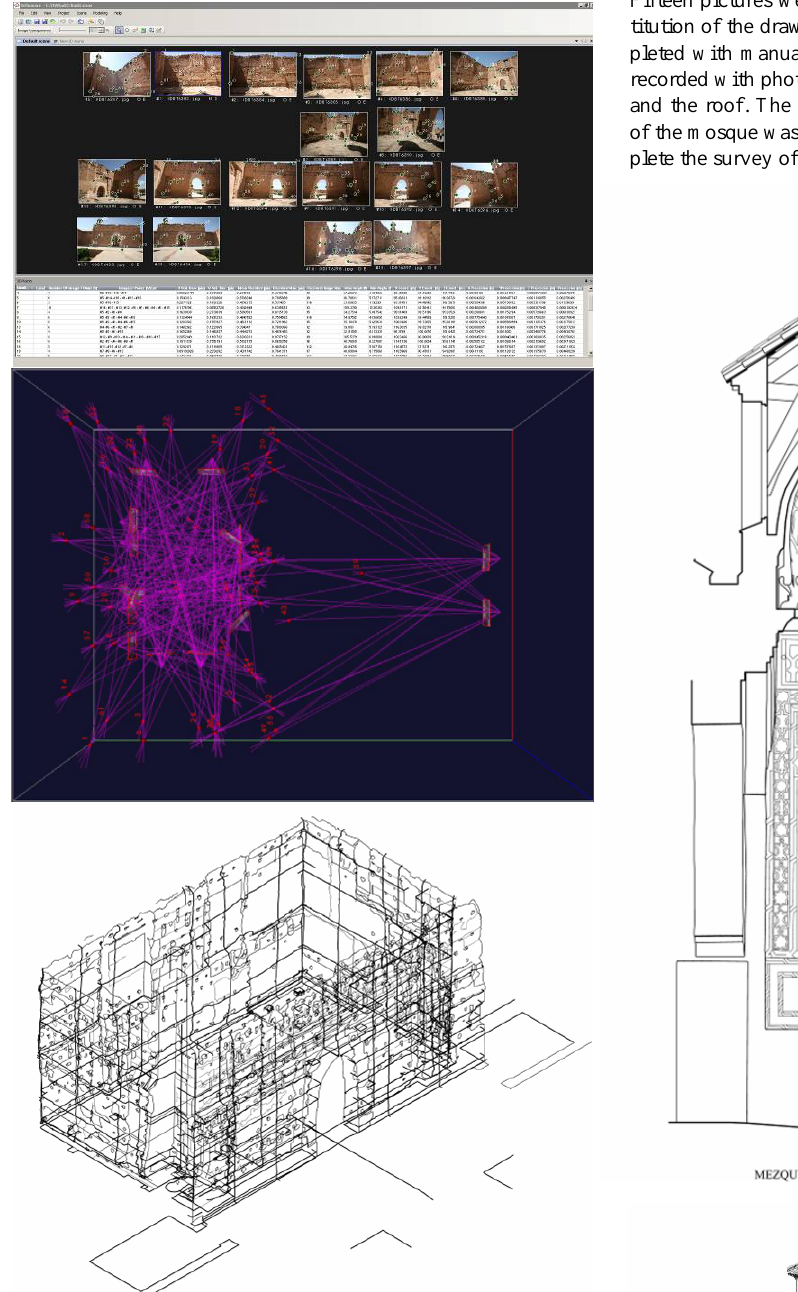
Figure 7. Block of photos, bundle adjustment and 3D model of the North hall of the palace al-Badi in Marrakech.